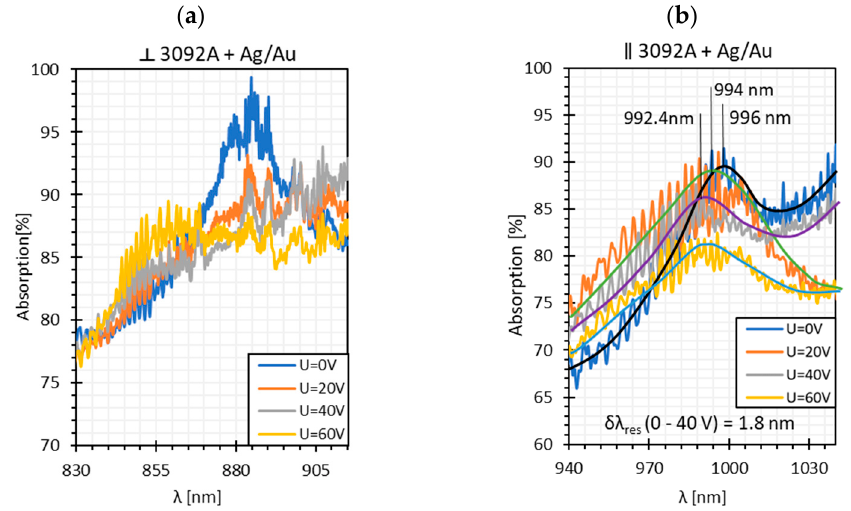
Figure 6. Absorption plots were obtained for ( a ) orthogonal and ( b ) parallel cells. The solid lines (black, blue, green, and purple) are the fitting curves obtained for the absorption plots.